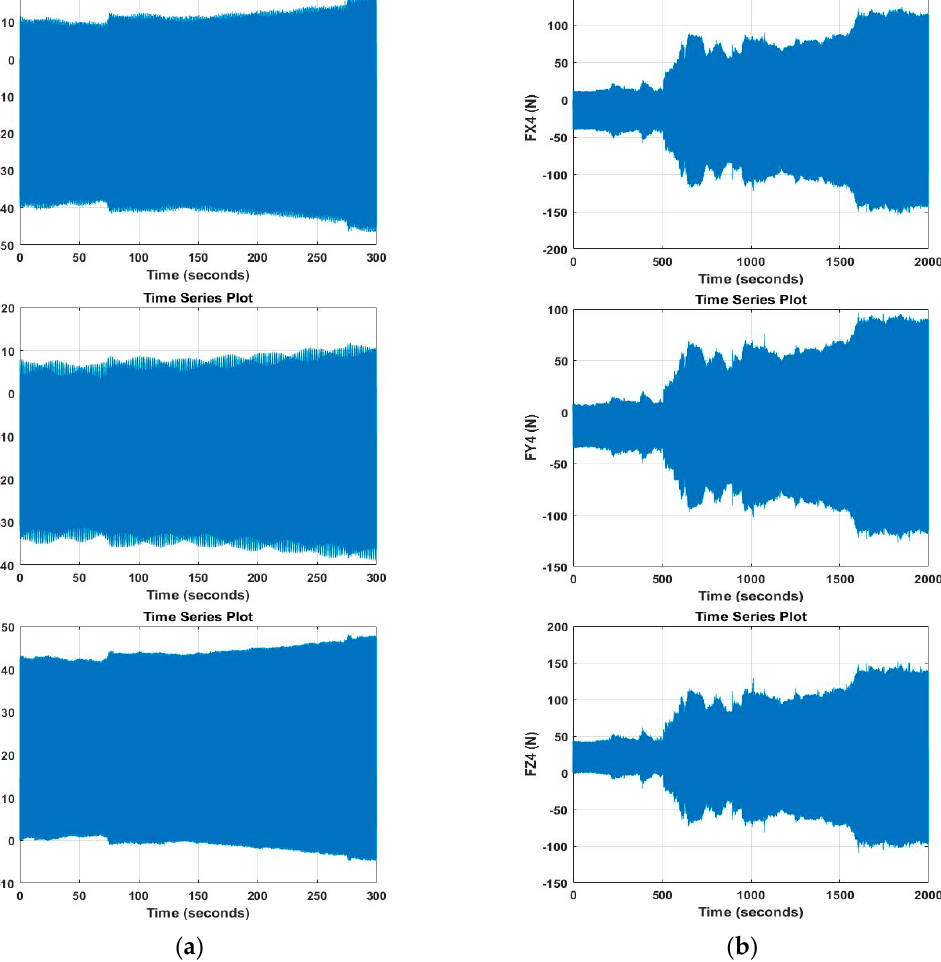
Figure 14. Force transmission results for bracket unit from GUI. ( a ) Results for case I; ( b ) Results for case II.